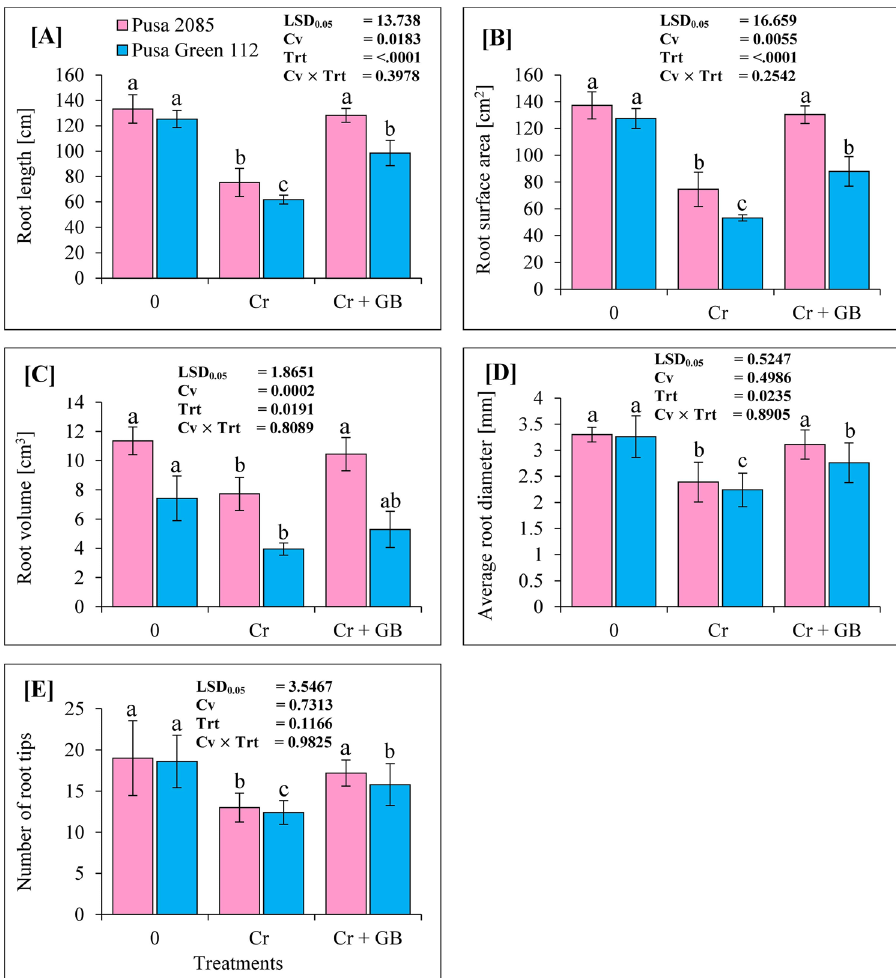
Figure 2. Effects of different stress levels of Glycine Betaine (GB) and Chromium (Cr), 0 and 120 μM Cr and 120 μM Cr + 100 mM (GB), on root morphological parameters: ( A ) root length (cm), ( B ) root surface area (cm 2 ), ( C ) root volume (cm 3 ), ( D ) average root diameter (mm), and ( E ) number of root tips of the two chickpea cultivars after 7 days of exposure (grown under hydroponics conditions). Generated data values are shown as the means of five replicates ± SE. The error bars indicated by the different letters represent significant differences, as tested by the least significant difference test ( p <